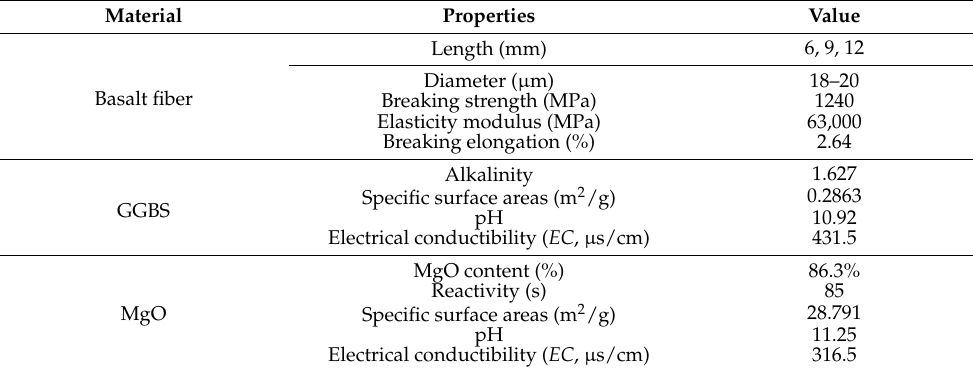
Table 3. Properties of the basalt fiber, GGBS, and MgO.